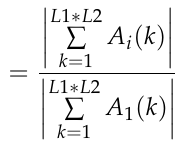
Table 4. Three kinds of height of selected areas. Case